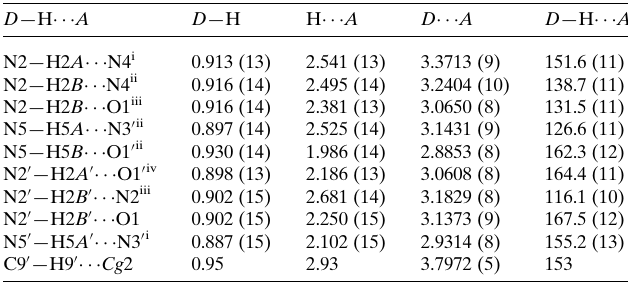
Table 2 Hydrogen-bond geometry (A˚ , (cid:3) ) for (II). Cg 2 is the centroid of the C8–C13 phenyl ring.